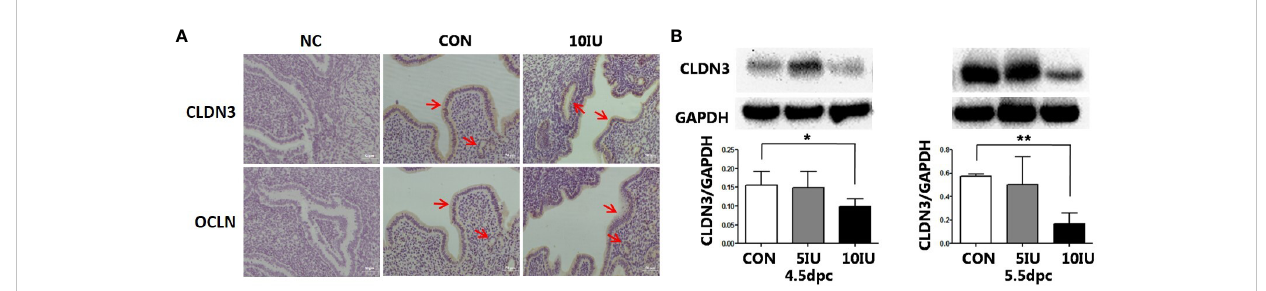
FIGURE 6 Localization and protein expression of the tight junction proteins CLDN3 and OCLN in the mouse endometrium at 4.5 dpc and 5.5 dpc among the CON, 5 IU and 10 IU groups. (A) Localization of CLDN3 and OCLN in the endometria of mice in the CON and 10 IU groups at 5.5 dpc. Bar=50 mm. (B) Protein expression of CLDN3 in the endometria of mice in the CON, 5 IU and 10 IU groups at 4.5 dpc and 5.5 dpc. NC: negative control Compared with the CON group, *p<0.05, **p<0.01. The arrows indicate the localization of target protein.